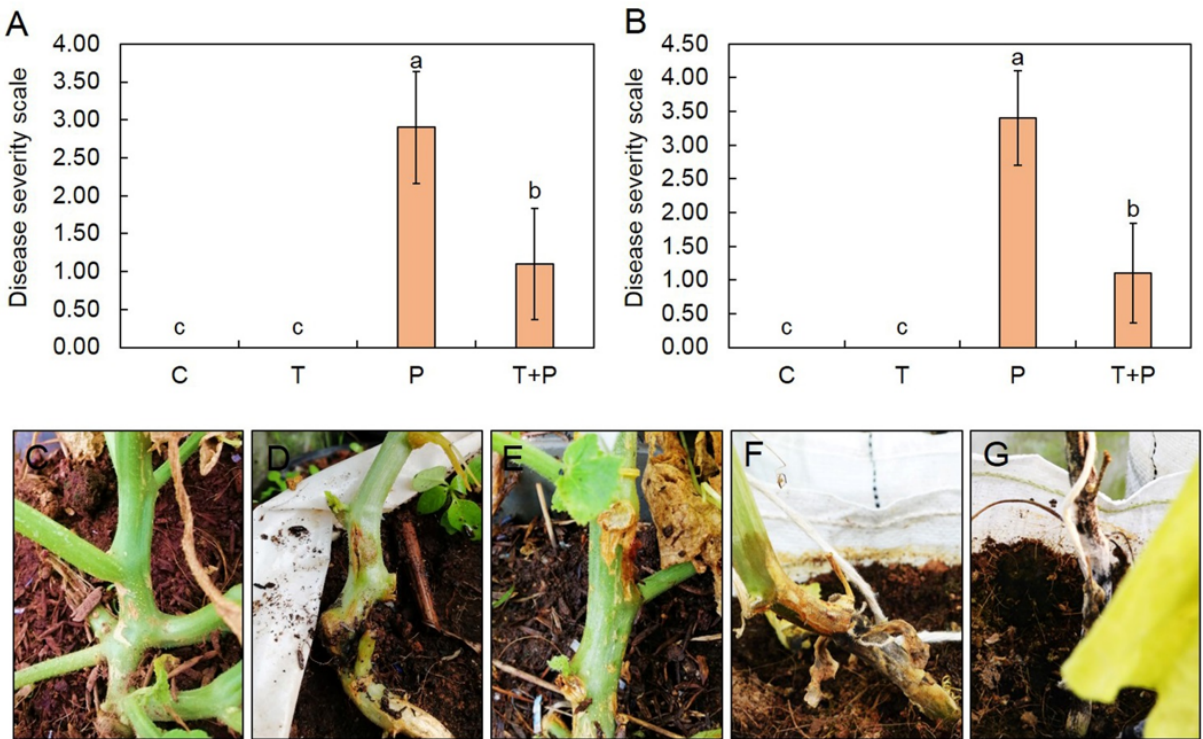
Figure 6. Qualitative disease severity scale of gummy stem blight in the first crop ( A ) and second crop ( B ). Representative images showing plants with qualitative severity scale ratings of: 0 ( C ), 1 ( D ), 2 ( E ), 3 ( F ), and 4 ( G ). T = T. asperelloides PSU-P1; P = S. cucurbitacearum; T + P = T. asperelloides PSU-P1 and S. cucurbitacearum . Different letters indicate statistically significant differences among treatments ( p < 0.01) using Mann–Whitney U test.